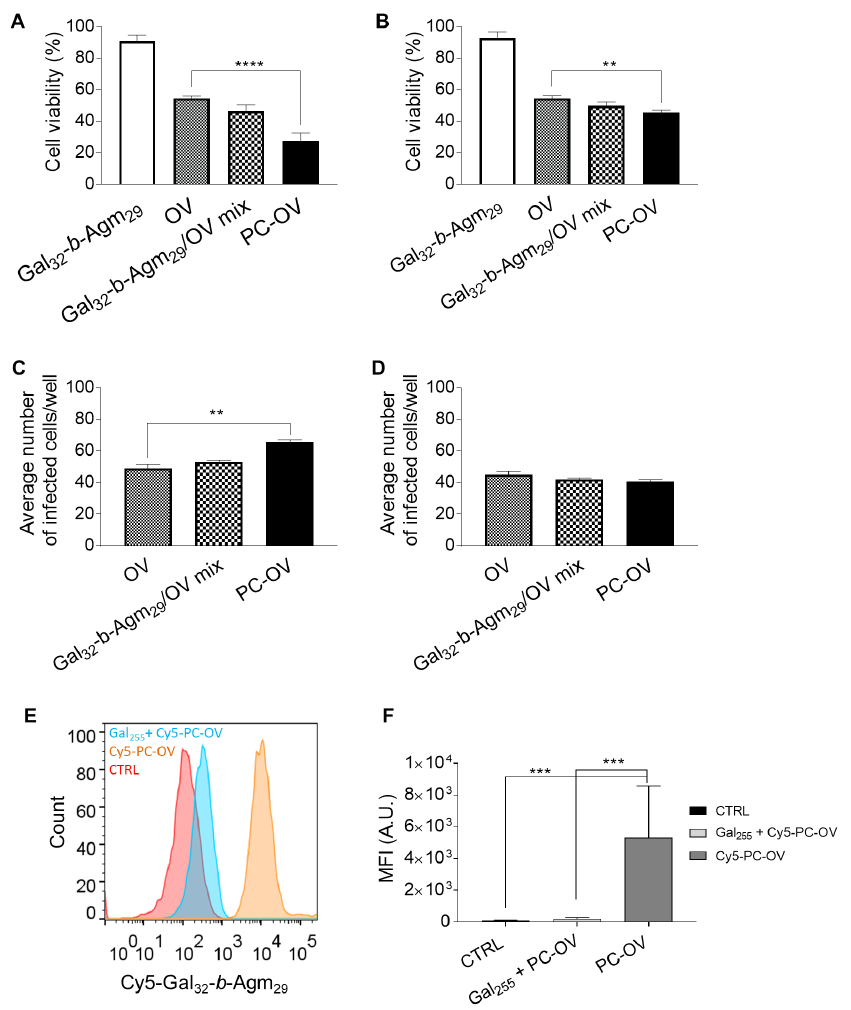
Figure 2. Cell viability, infection titer, and competition studies. ( A , B ) In vitro cytotoxicity of naked OV, Gal 32 - b -Agm 29 alone, Gal 32 - b -Agm 29 /OV mix, and PC-OV was measured by a MTS cell-viability assay at day 3 post-treatment on ( A ) HepG2 and ( B ) A549 cells. Control untreated cells were used as reference (100% cell viability); ( C , D ) the infectivity of naked OV, Gal 32 - b -Agm 29 /OV mix, and PC-OV was assessed by ICC assay in HepG2 ( C ) and A459 ( D ) cell lines, based on visual quantification of infected cells after the staining of virus hexon protein. For every five replicates, five images of non-overlapping fields were acquired using an AMG EVO XL microscope. For infectivity comparison, the data are presented as the average number of infected cells per well. Error bars, mean ± SEM: ** p < 0.01; **** p < 0.0001. ( E , F ) Flow cytometry histogram showing cellular uptake of Cy5-Gal 32 - b -Agm 29 after incubation with Cy5-Gal 32 - b -Agm 29 /OV complex (Cy5-PC-OV) along with control (CTRL) cells ( E ) and comparative median fluorescence intensity (MFI) ( F ) of control cells (CTRL), cells pre-incubated with Gal 255 polymer followed by incubation with Cy5-PC-OV (Gal 255 + Cy5-PC-OV), and cells incubated with Cy5-PC-OV only. Error bars, mean ± SD; *** p <